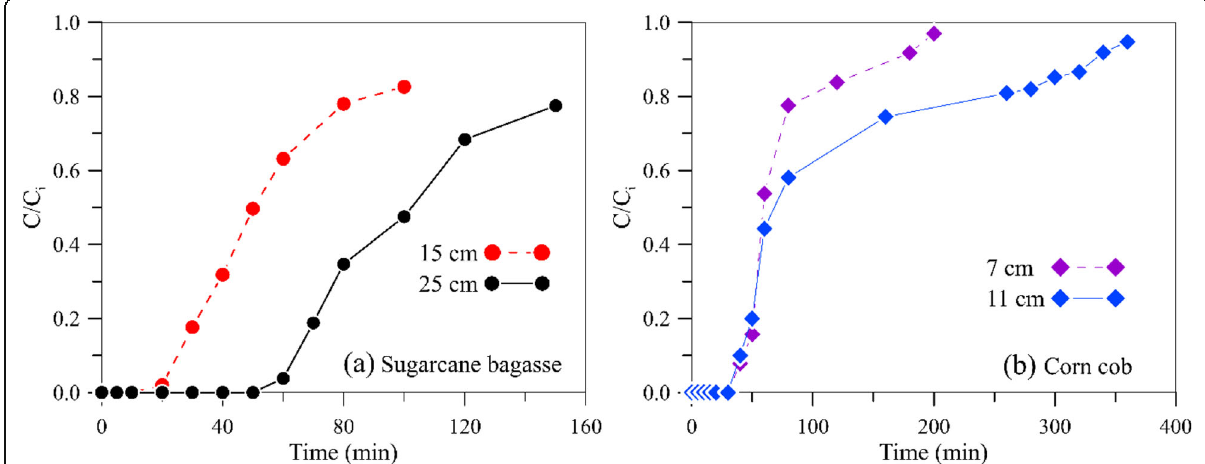
Fig. 4 Influence of bed height on the breakthrough curve of the SMX adsorption with an initial concentration of 5 mg L − 1 and 2 mL min − 1 of flow rate